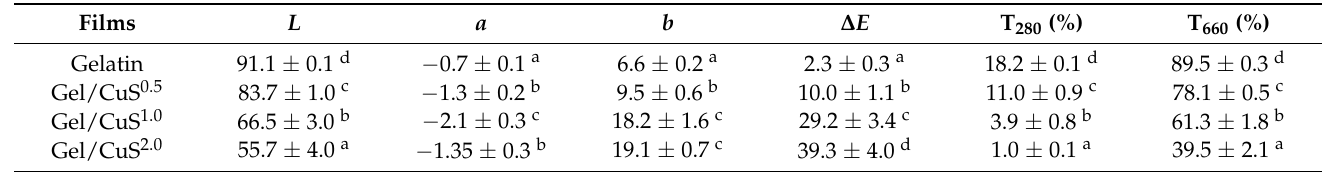
Table 2. Optical properties of gelatin/CuSNP